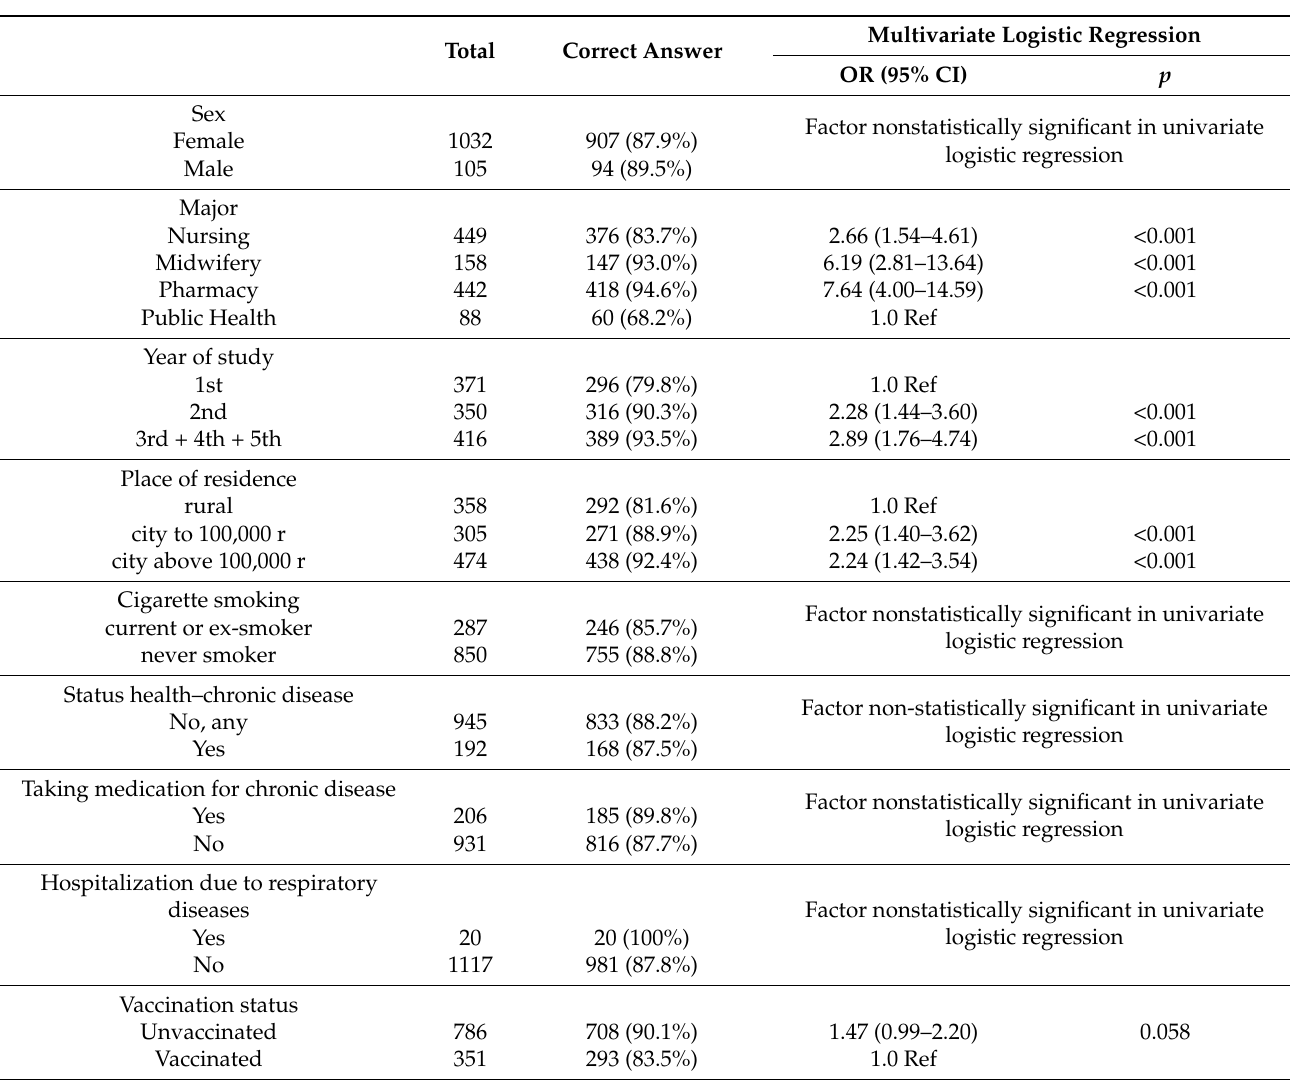
Table 5. Associations between the demographic factors (sex, major, year of study, place of residence, smoking cigarettes, status health, taking medication, and vaccination status) and the students’ knowledge about the effectiveness of the influenza